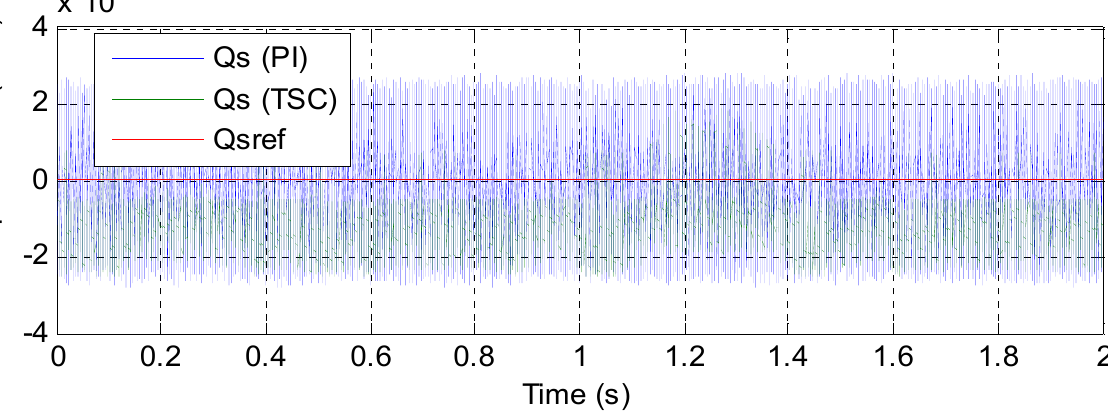
Figure 18. Reactive power.